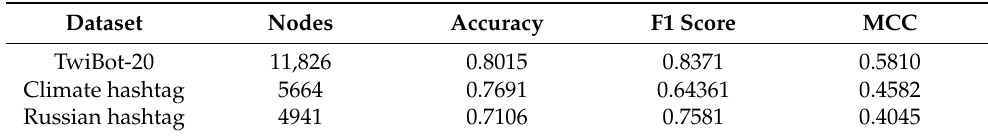
Table 6. RF results for all datasets, after using Botometer for both hashtags, compared to TwiBot-20.